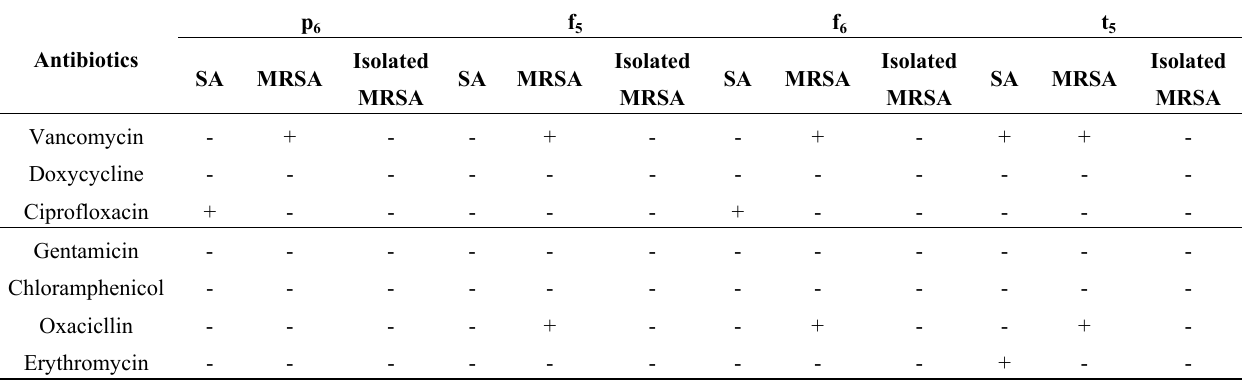
Table 3. Antibacterial coordination ability results.